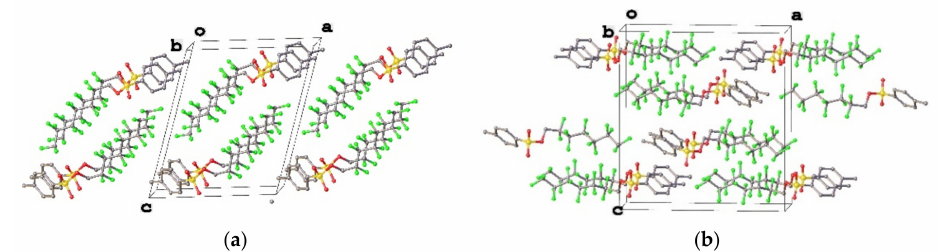
Figure 9. Crystal packing of polymorphs 3a ( a ) and 3b ( b